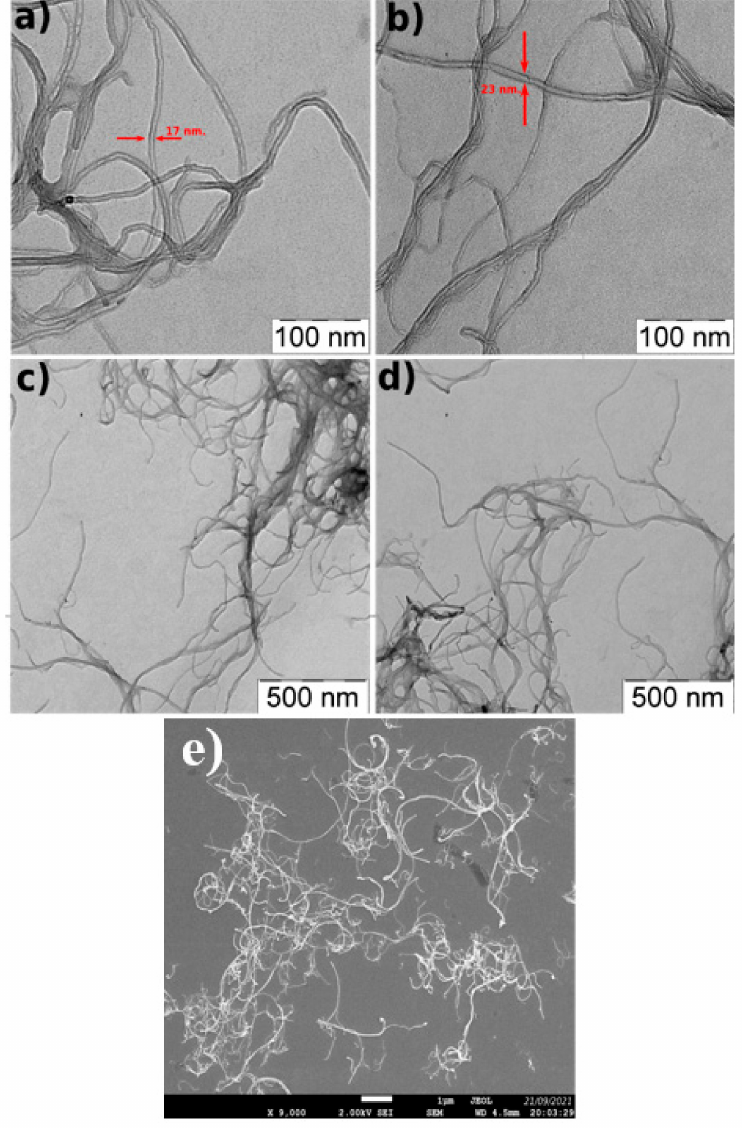
Figure 3. Image in MWCNT in TEM ( a – d ) and SEM ( e ).